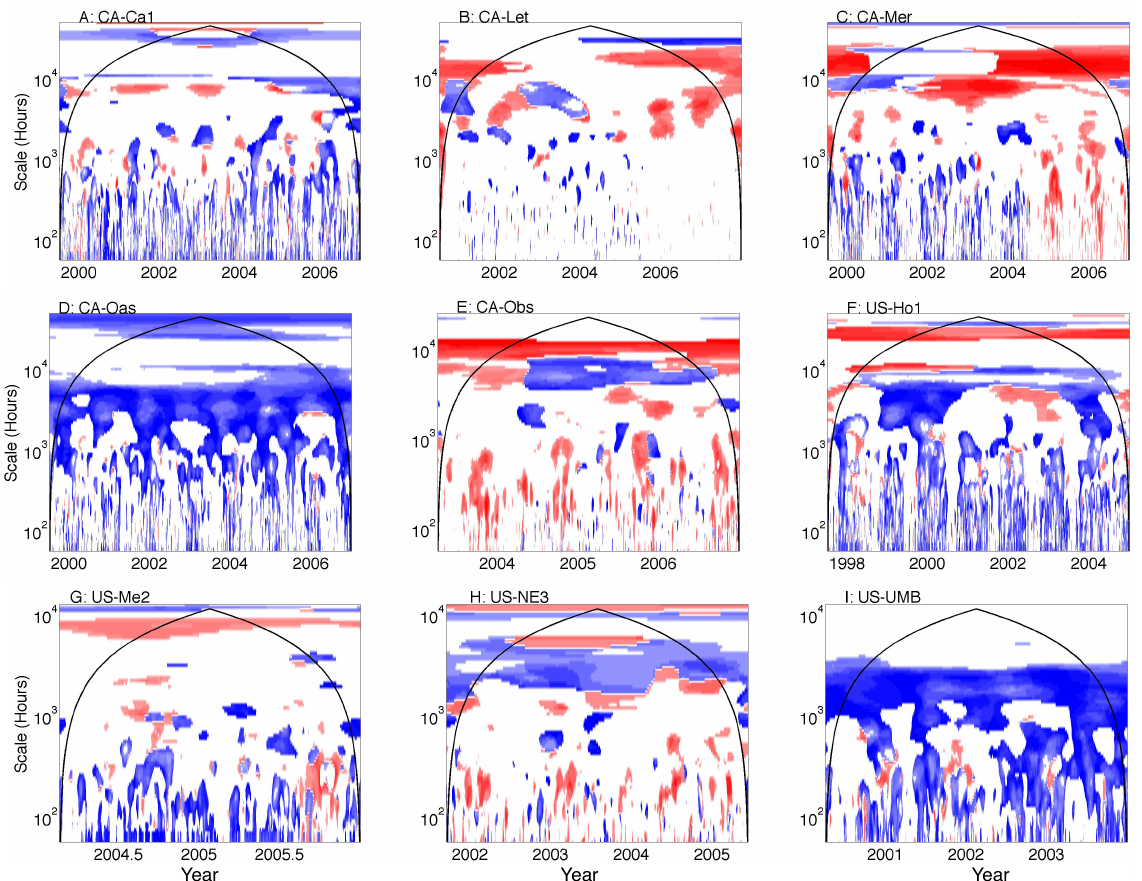
Fig. 9. The ratio of wavelet coherence significance tests for the model using a data assimilation procedure (LoTEC) versus other models that do not use data assimilation. The color bar follows Fig. 5. Periods and scales in time for which LoTEC is significantly related to NEE measurements and other models are not significantly related to NEE measurements (on average) are shown as dark blue. Regions for which models other than LoTEC are significantly related to NEE measurements and LoTEC is not significantly related to NEE measurements are shown as dark red. The color bar follows Fig.